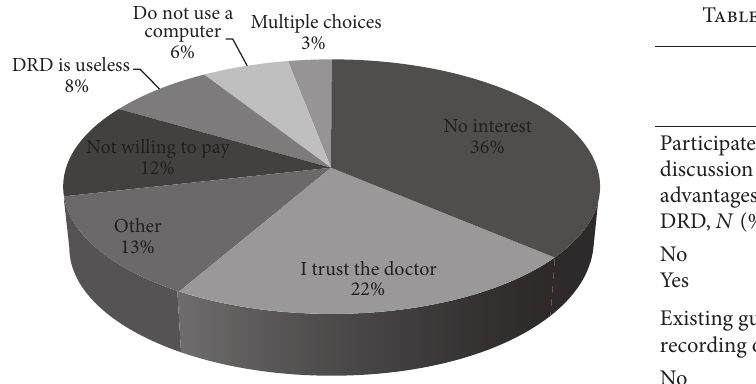
Figure 2: Patients’ reasoning for lack of interest in a digital documentation of the procedure.